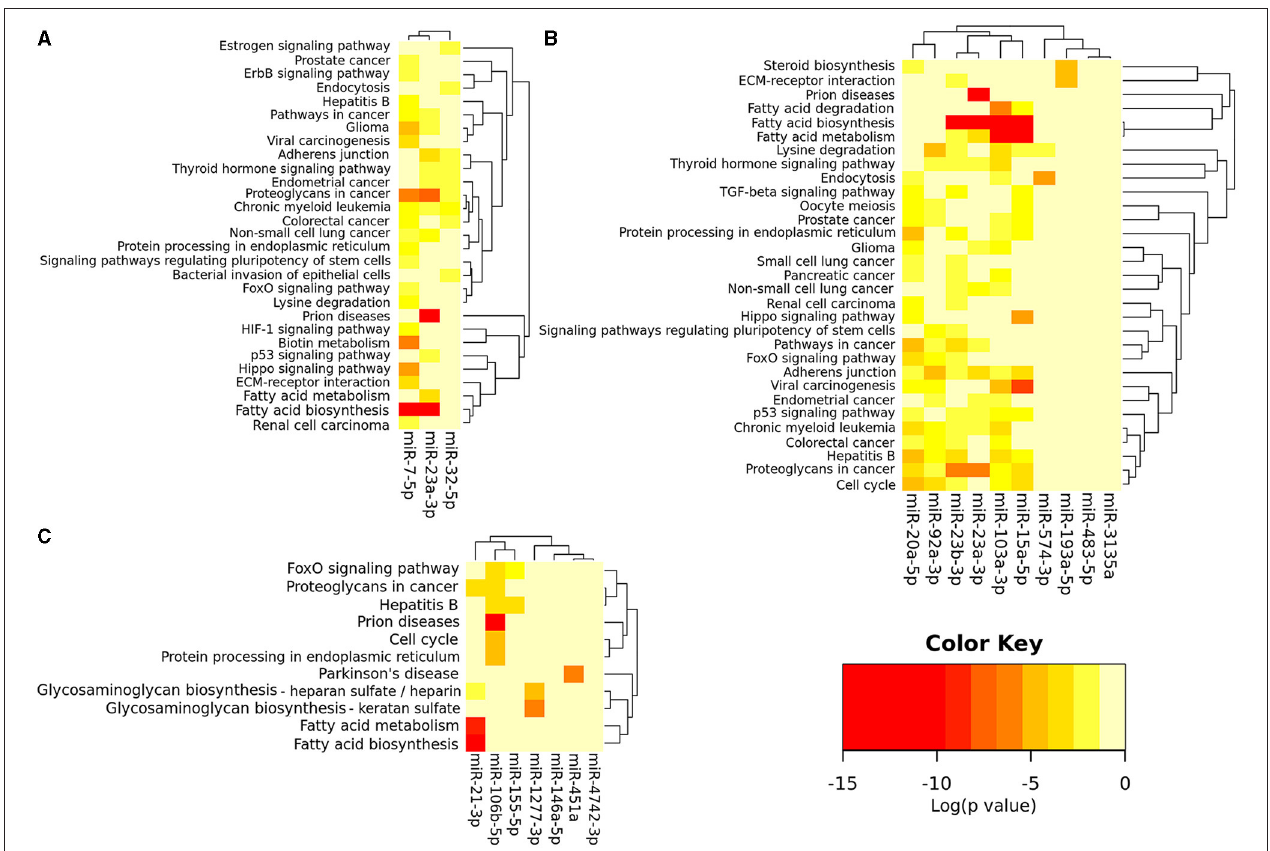
FIGURE 2 | miRNAs vs. pathways heatmap (Clustering based on significance levels) of the consistently dysregulated ASD-miRNAs in blood and immune cells (A) , saliva (B) , and brain tissue (C) . The heatmap was created from the DIANA mirPath v 3.0. Darker shades represent more significant. Dendrograms depicts hierarchical clustering results for miRNAs and pathways, respectively. The miRNA axis represents the clustered miRNAs with similar pathway targeting patterns. A similar clustering is shown on the pathway axis. Interactions dataset: TarBase v7.0; Analysis: pathways union; p -value threshold: 0.05; FDR Correction, Conservative